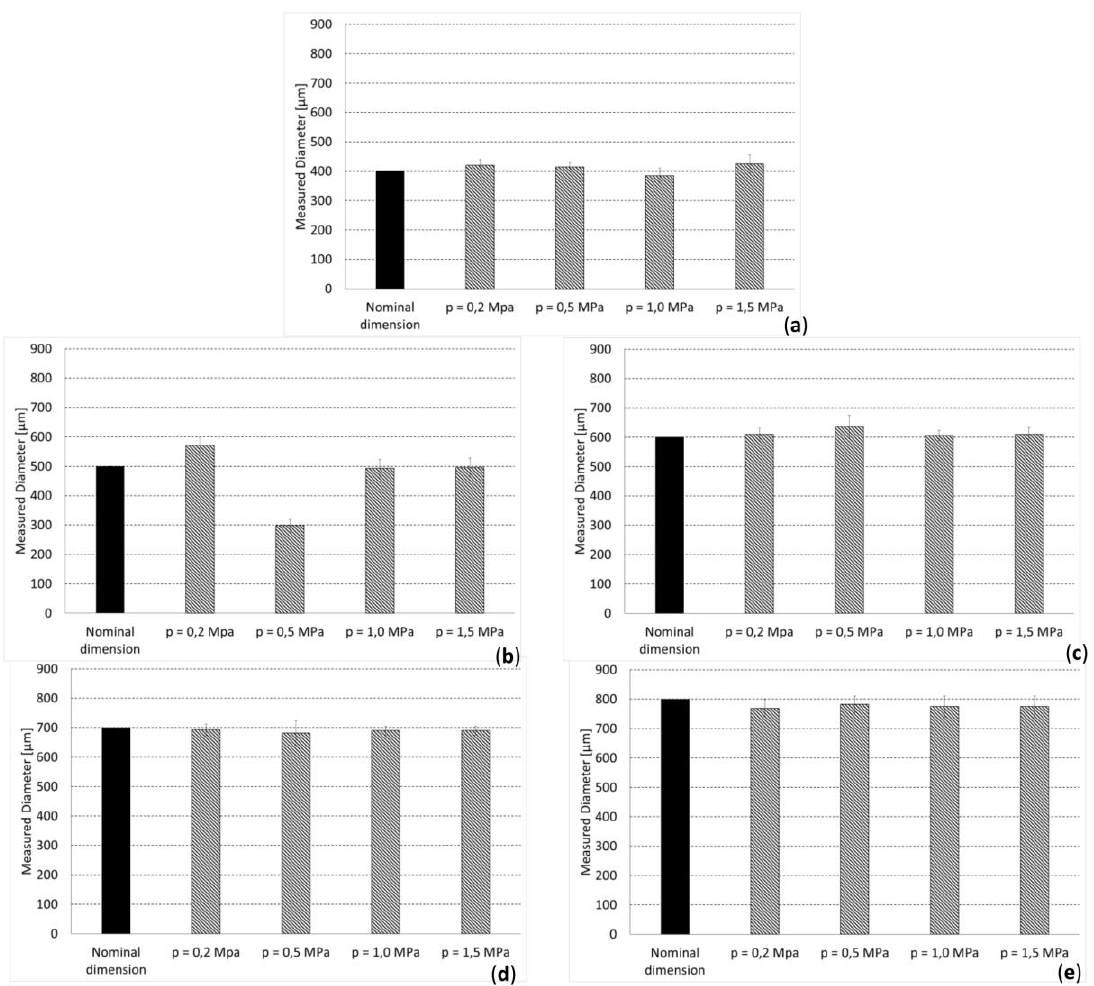
Figure 10. Comparison between measured and nominal dimension of diameter: ( a ) D = 400 µm; ( b ) D = 500 µm; ( c ) D = 600 µm; ( d ) D = 700 µm; ( e ) D = 800 µm.